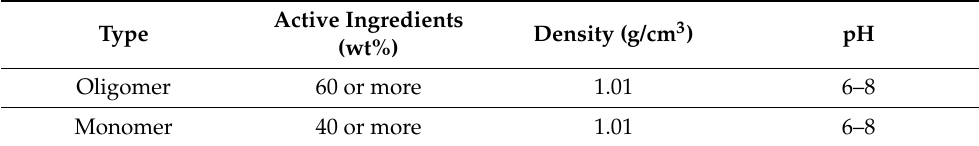
Table 2. Physical properties and chemical composition of water repellent.